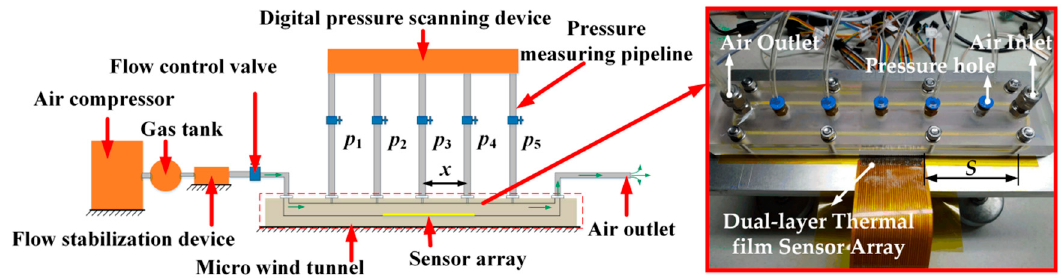
Figure 4. Schematic diagram and photograph of micro-wind tunnel system. The wall static pressures were measured by the pressure scanner. Δ x = 4 cm, h = 0.535 mm.